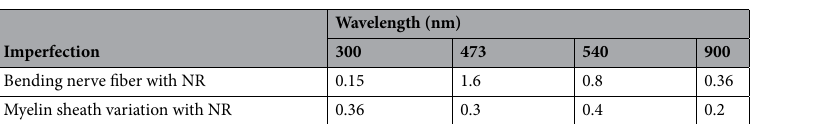
Table 7. Orders of magnitude the transmission for typical wavelengths in a bending nerve fiber and myelin sheath variation compared to a normal nerve fiber when light launched to